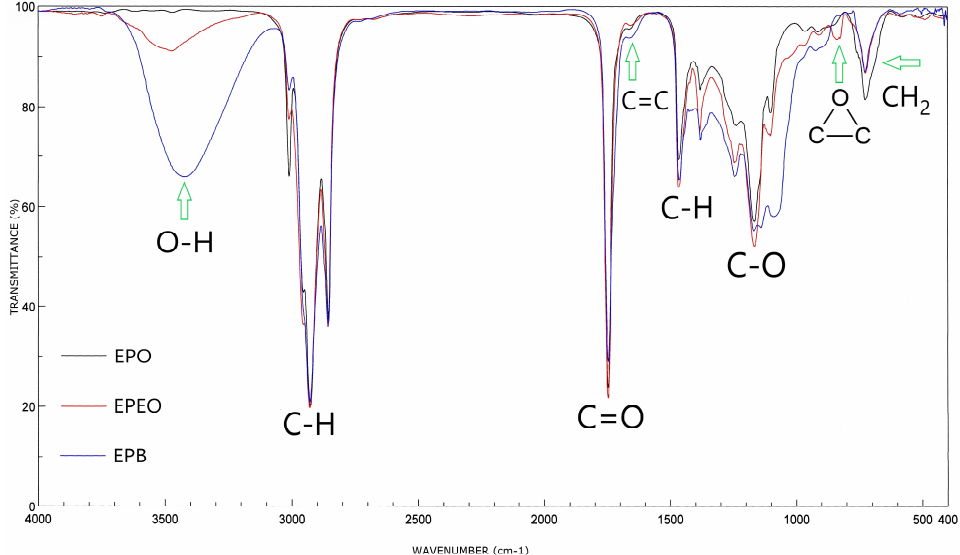
Figure 4. Fourier transform infrared (FTIR) spectra of EPO, EPEO, and EPB.